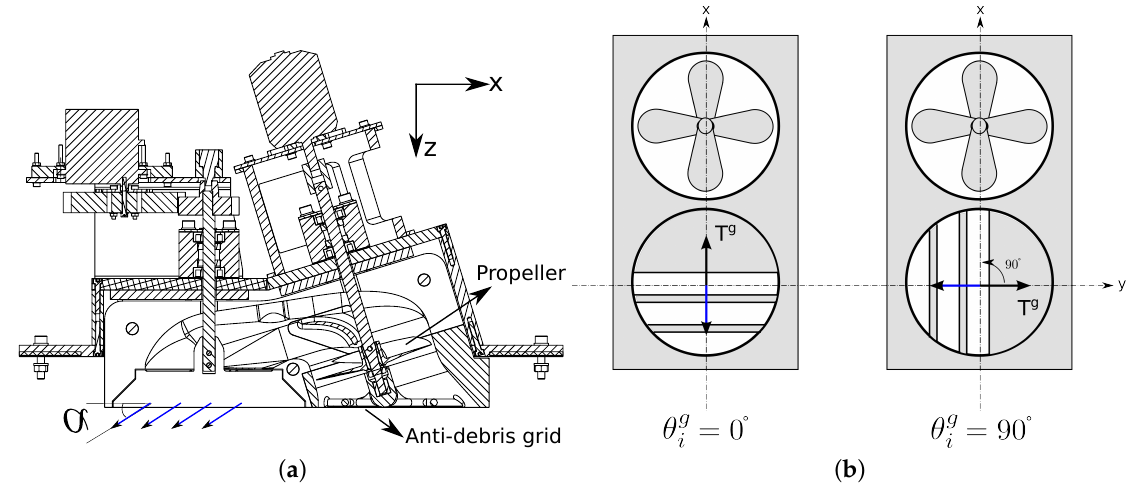
Figure 3. 360-degrees-steerable steering-grid bow thruster: ( a ) longitudinal cross section at its symmetry plane, and ( b ) abstract top view of its bottom section for θ g